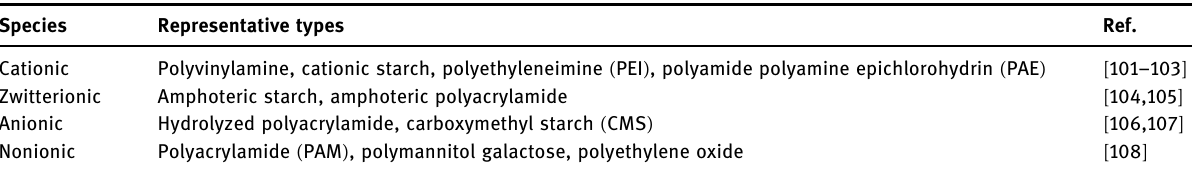
Table 3: Filtration reagents used in pulp and paper production